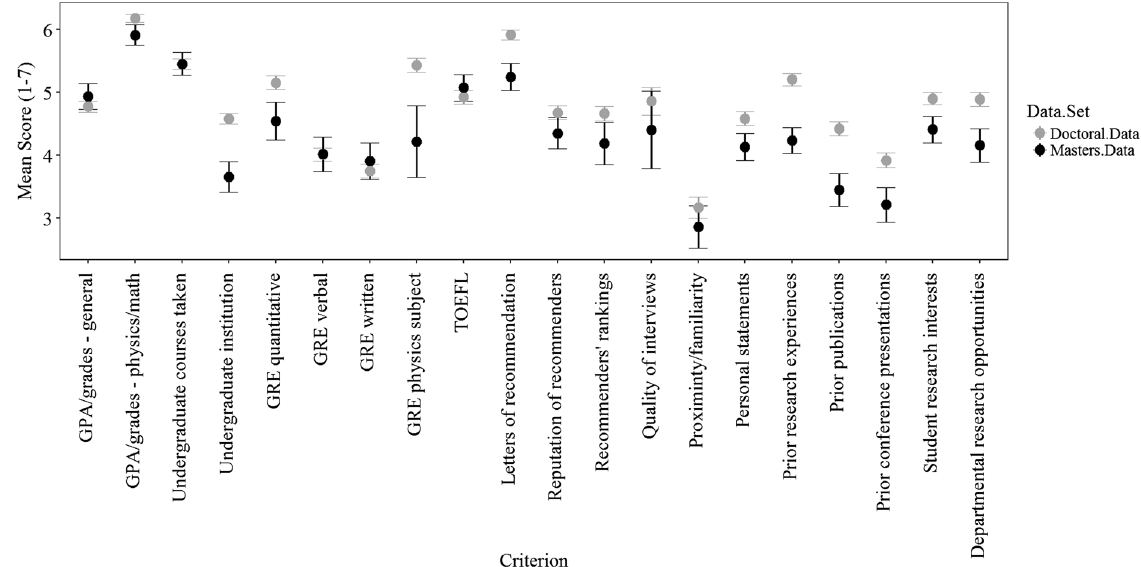
FIG. 2. Mean response of various admission criteria in all master ’ s ( n ¼ 43 ) and Ph.D. ( n ¼ 149 ) programs.